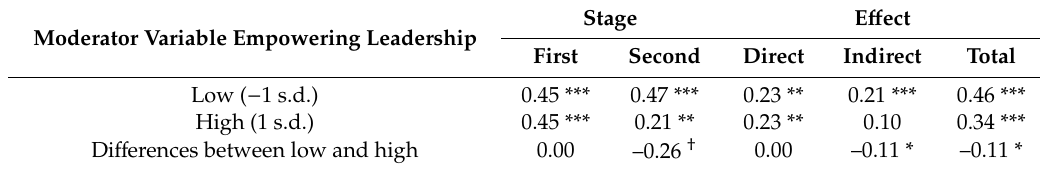
Table 3. Results of moderated mediation e ff